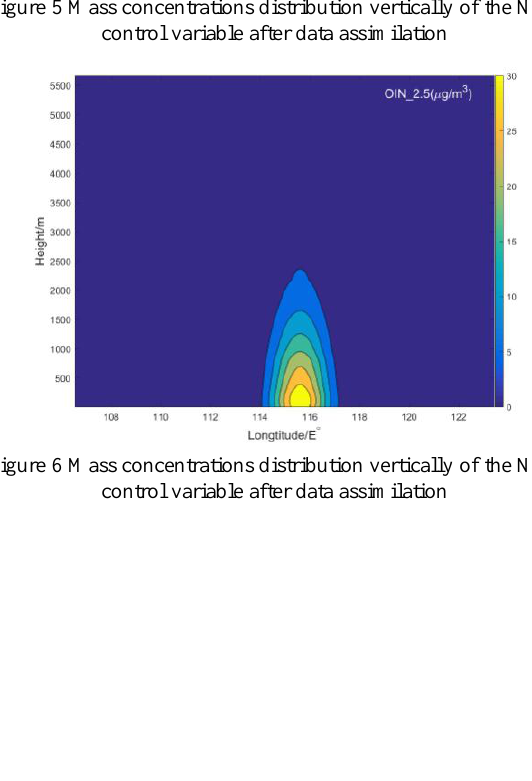
Figure 5 Mass concentrations distribution vertically of the No.7 control variable after data assimilation